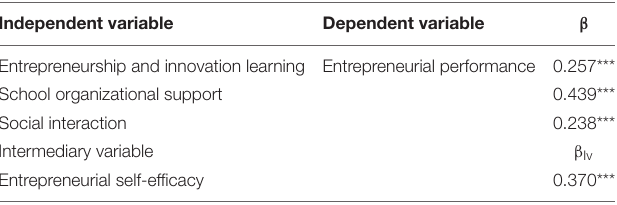
TABLE 6 | Test for the intermediary role of entrepreneurial self-efficacy in entrepreneurship education and entrepreneurial performance. Independent